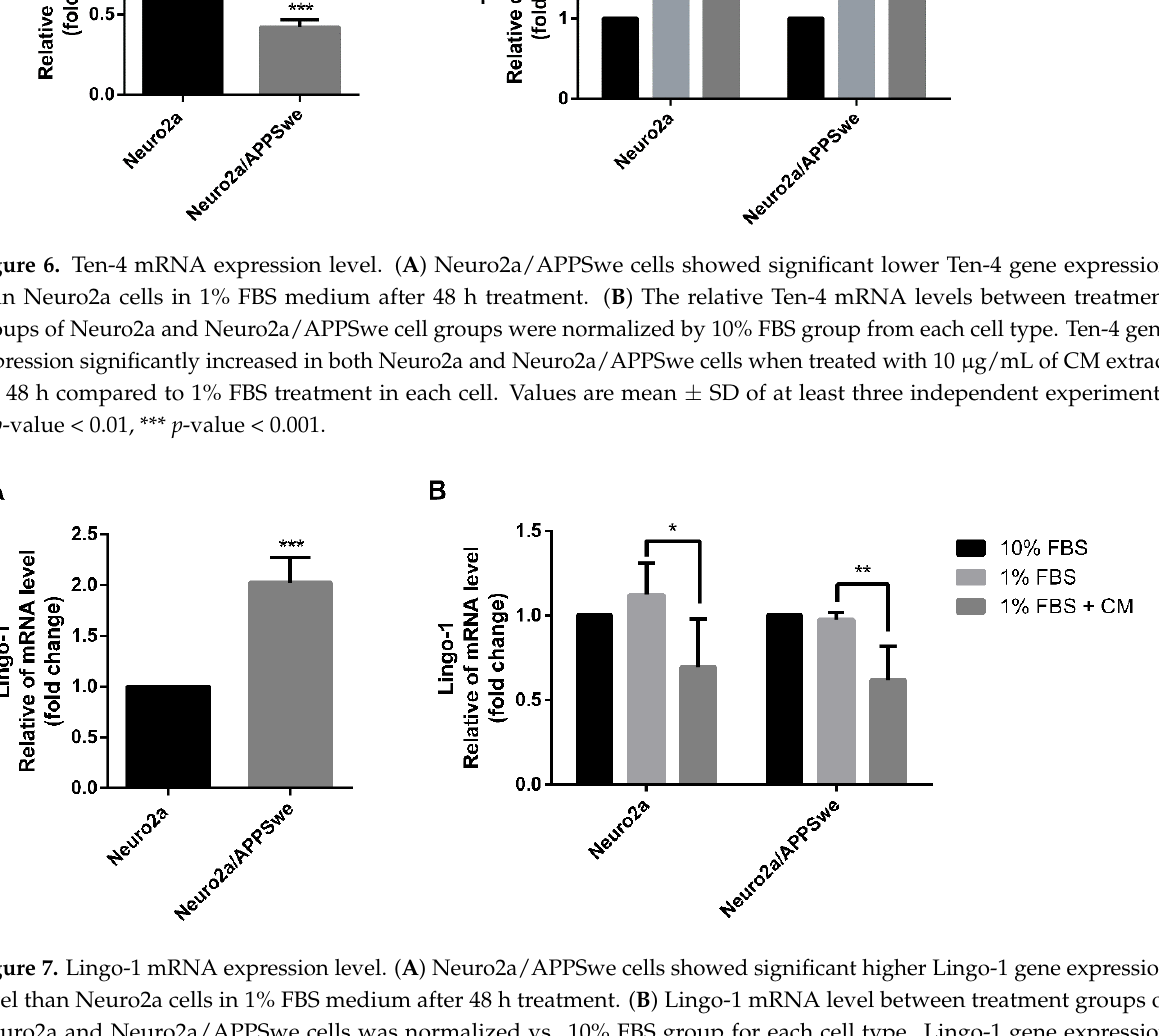
Figure 6. Ten-4 mRNA expression level. ( A ) Neuro2a/APPSwe cells showed significant lower Ten-4 gene expression than Neuro2a cells in 1% FBS medium after 48 h treatment. ( B ) The relative Ten-4 mRNA levels between treatment groups of Neuro2a and Neuro2a/APPSwe cell groups were normalized by 10% FBS group from each cell type. Ten-4 gene expression significantly increased in both Neuro2a and Neuro2a/APPSwe cells when treated with 10 µg/mL of CM extract for 48 h compared to 1% FBS treatment in each cell. Values are mean ± SD of at least three independent experiments. ** p- value < 0.01, *** p- value < 0.001.